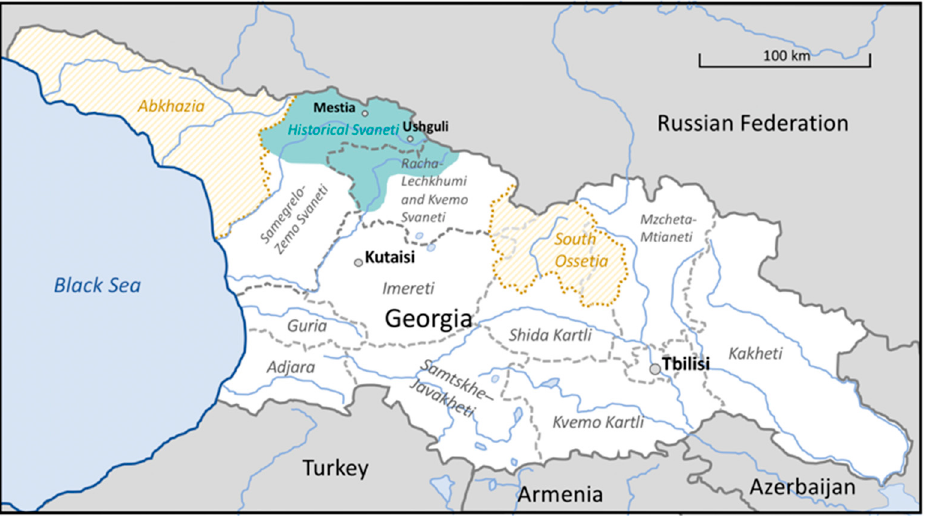
Figure 1. Placement of the historical region of Svaneti in the recent political map of Georgia according to regions with the zones of the Abkhazian and South Ossetian conflict (Applis 2022).